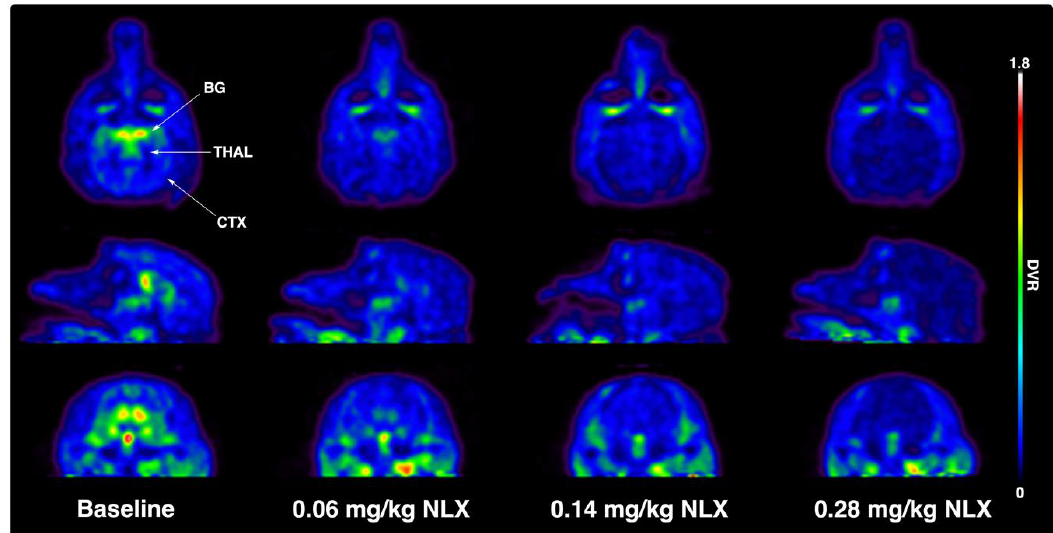
Figure 1. Representative transverse (top row), sagittal (middle row), and coronal (bottom row) monkey positron emission tomography (PET) images of a [ 11 C]CFN baseline scan and following blocking studies with low (0.06 mg/kg), medium (0.14 mg/kg), and high (0.28 mg/kg) doses of naloxone (NLX). Images are distribution volume ratio (DVR) images summed 0–60 min following intravenous (IV) injection of the radiotracer. BG = basal ganglia, THAL = thalamus, CTX = cortex.